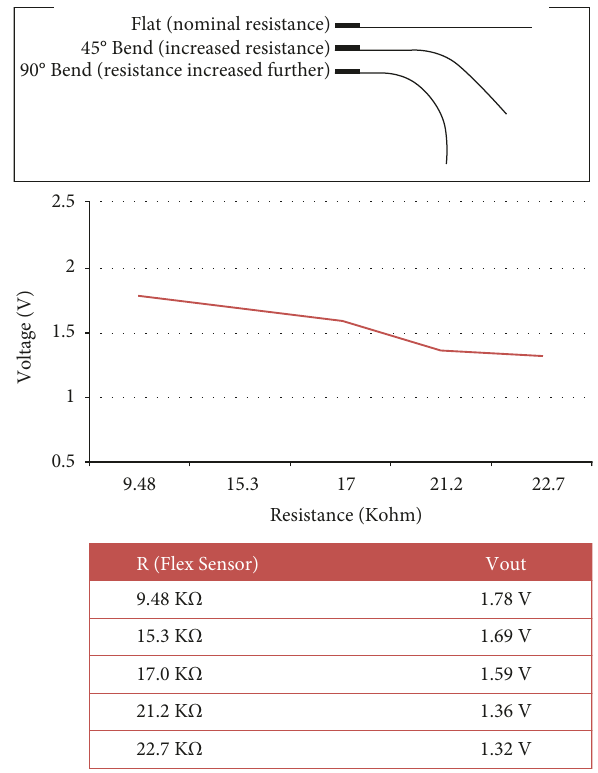
Figure 5: Flex sensor variation.